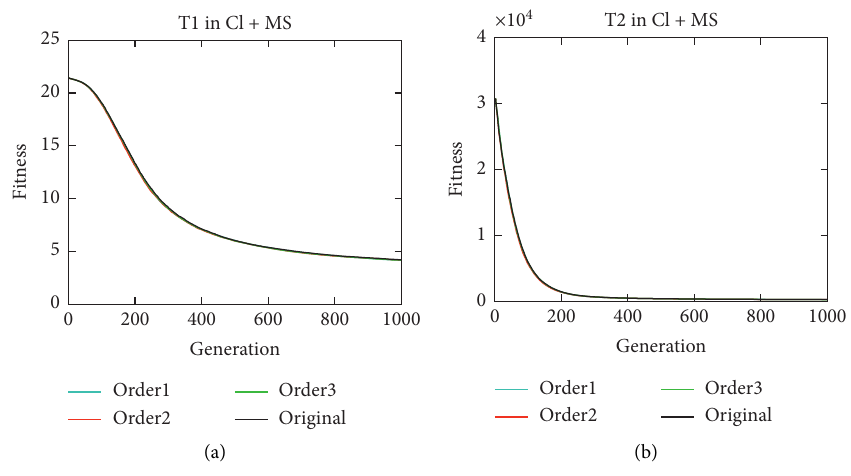
Figure 5: Convergence of MFEA for problem 2